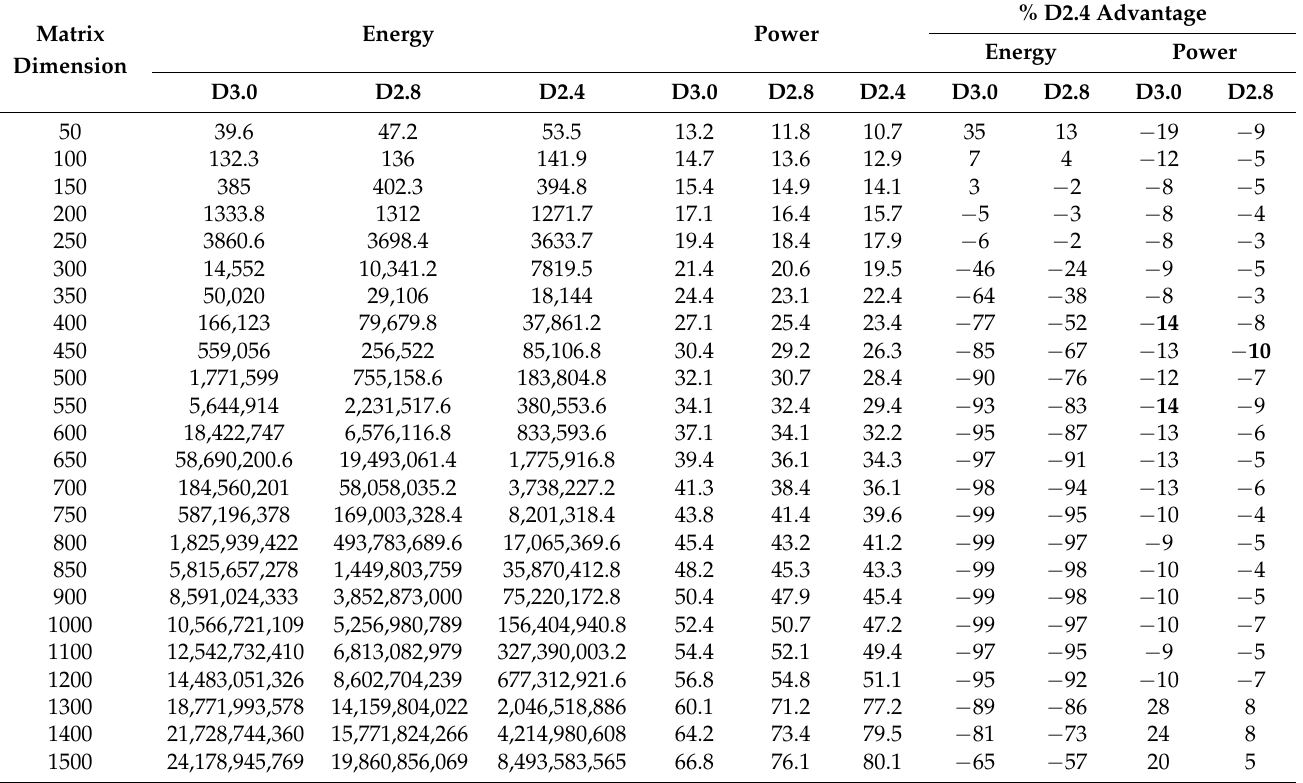
Table 2. Average energy in millijoules (mJ), power in watts, and percentage difference of D2.4 relative to the other methods, where negative indicates better performance. The region of best power savings is marked.